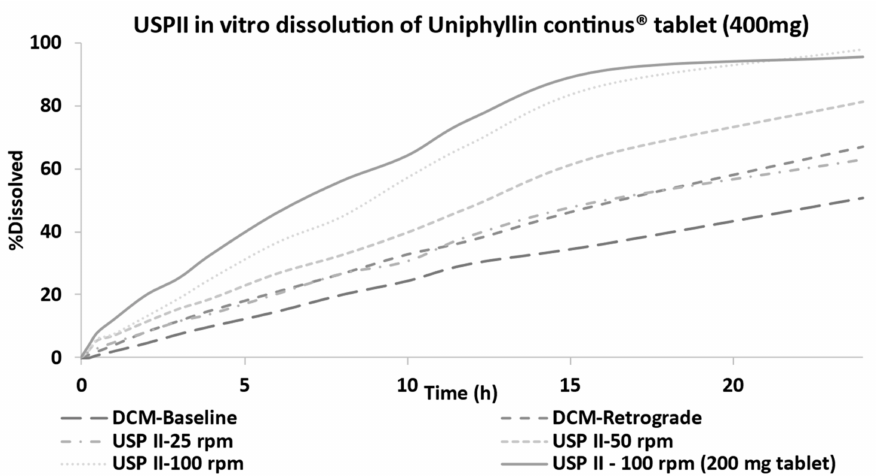
Figure 1. Average in vitro dissolution profiles of the Uniphyllin Continus ® tablet (400 mg) in the USP II (25, 50 and 100 rpm) and DCM (baseline and retrograde motility